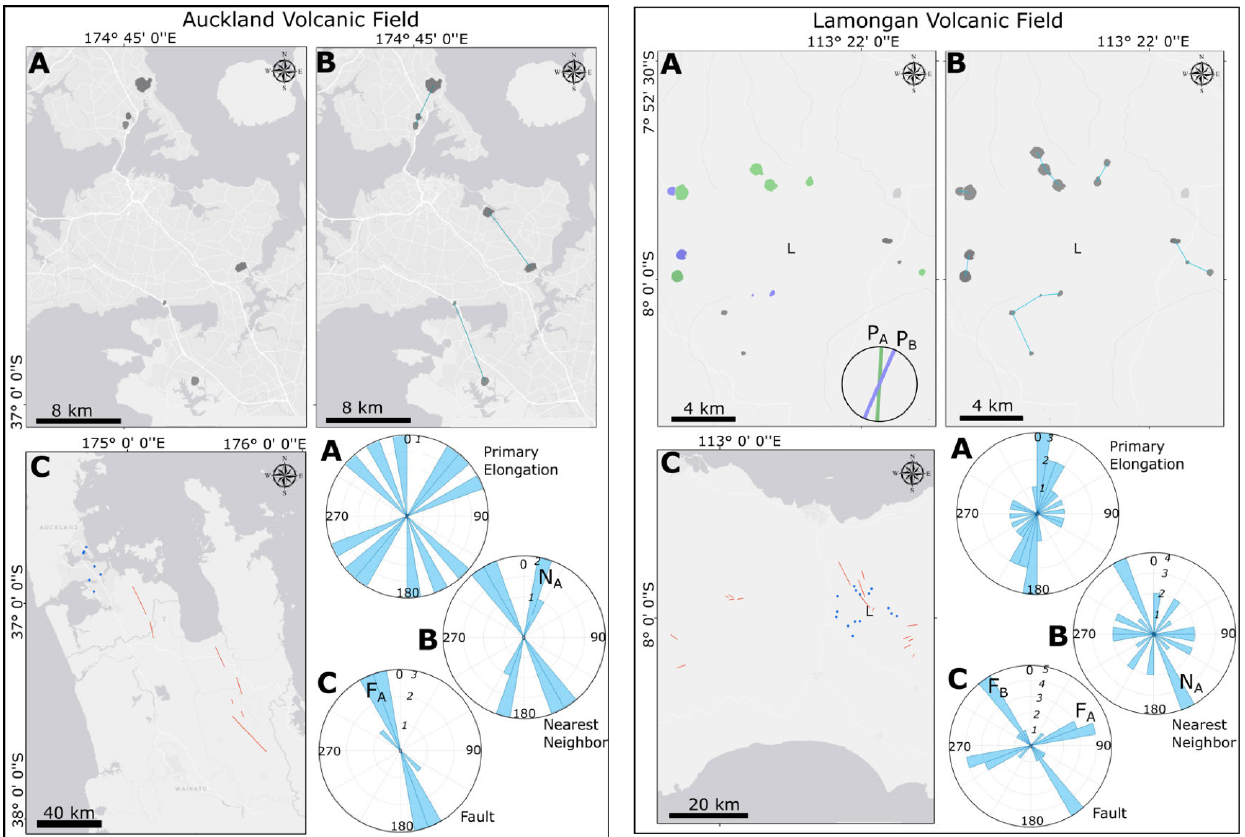
Figure 5: Lamongan Volcanic Field spatial (map) and orientation data (rose diagram). [A] Maars measured for primary elongation orientation. Colors reflect orien- tation modes Green (PA), Blue (PB), Grey (none). The summit of Lamongan Stratovolcano indicated by L. [B] Digitized maars and nearest neighbor lines. [C] Regional view with digitized maars (blue dots) and fault lines (red